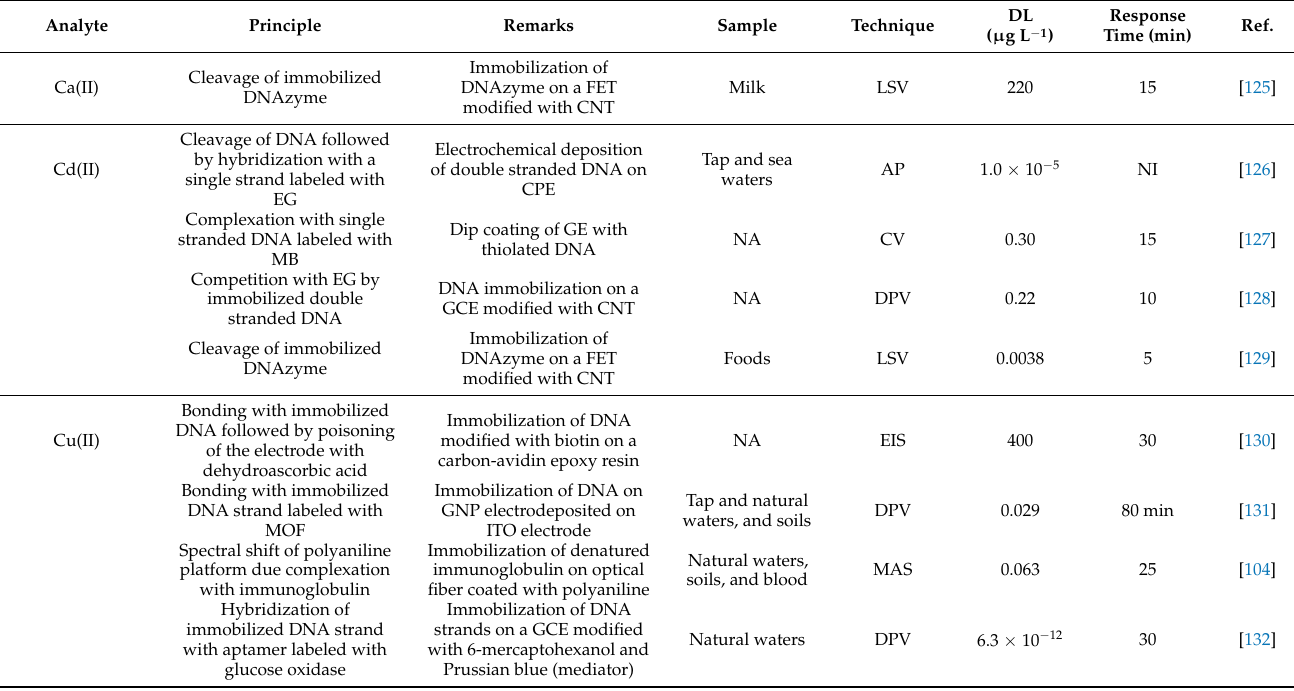
Table 3. Selected applications of biosensors based on